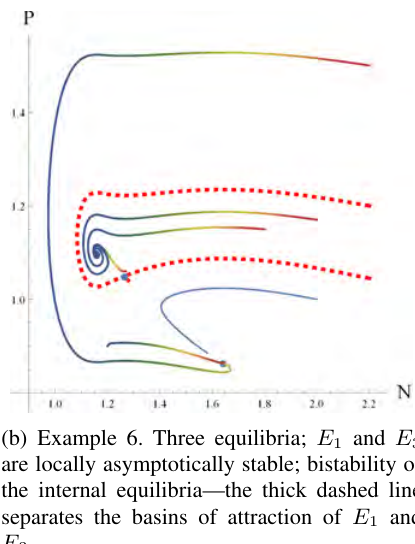
Fig. 12. Dynamics of system (4) in the case of three internal equilibrium